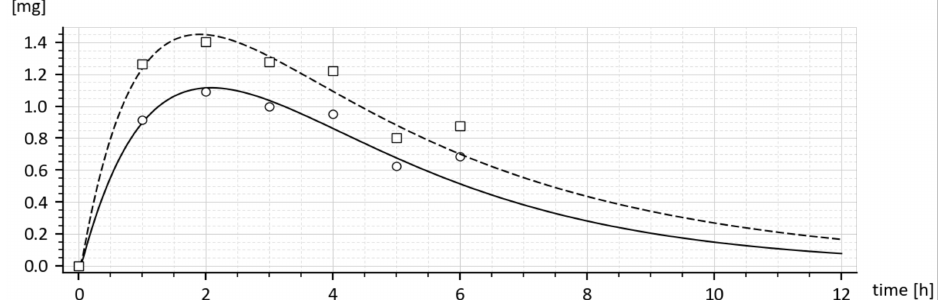
Figure 1. Drug amounts M and m obtained from the in-vivo experiment with (dashed curve) and without (full curve) of the added tenside, respectively.